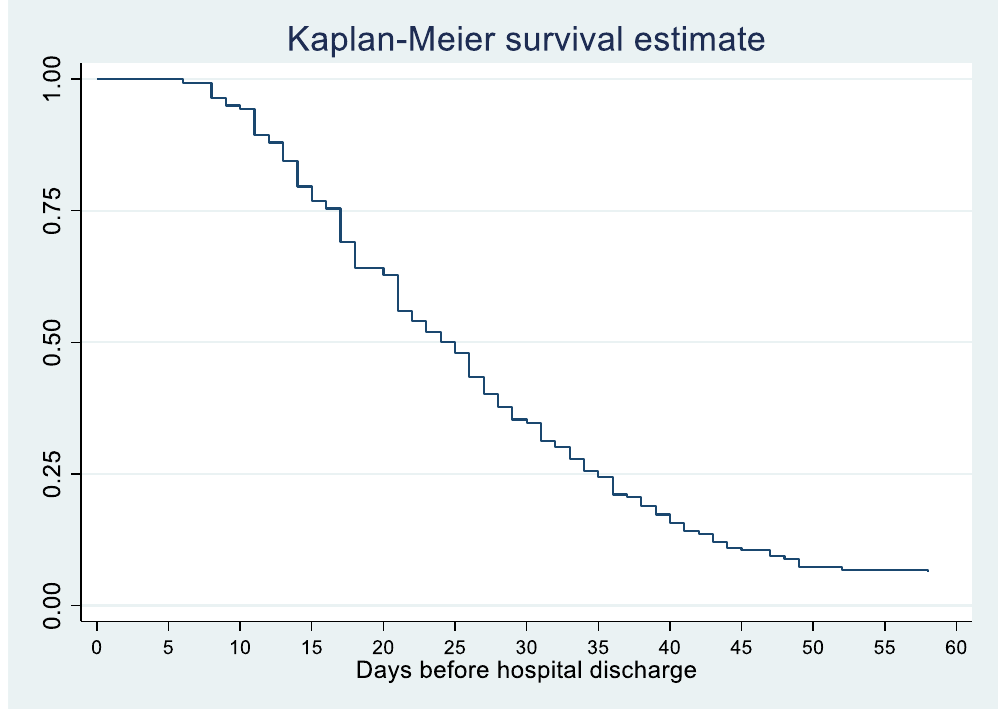
Figure 1. HIV-associated disseminated histoplasmosis: Days in hospital before discharge or death. 1981–2014, French Guiana.